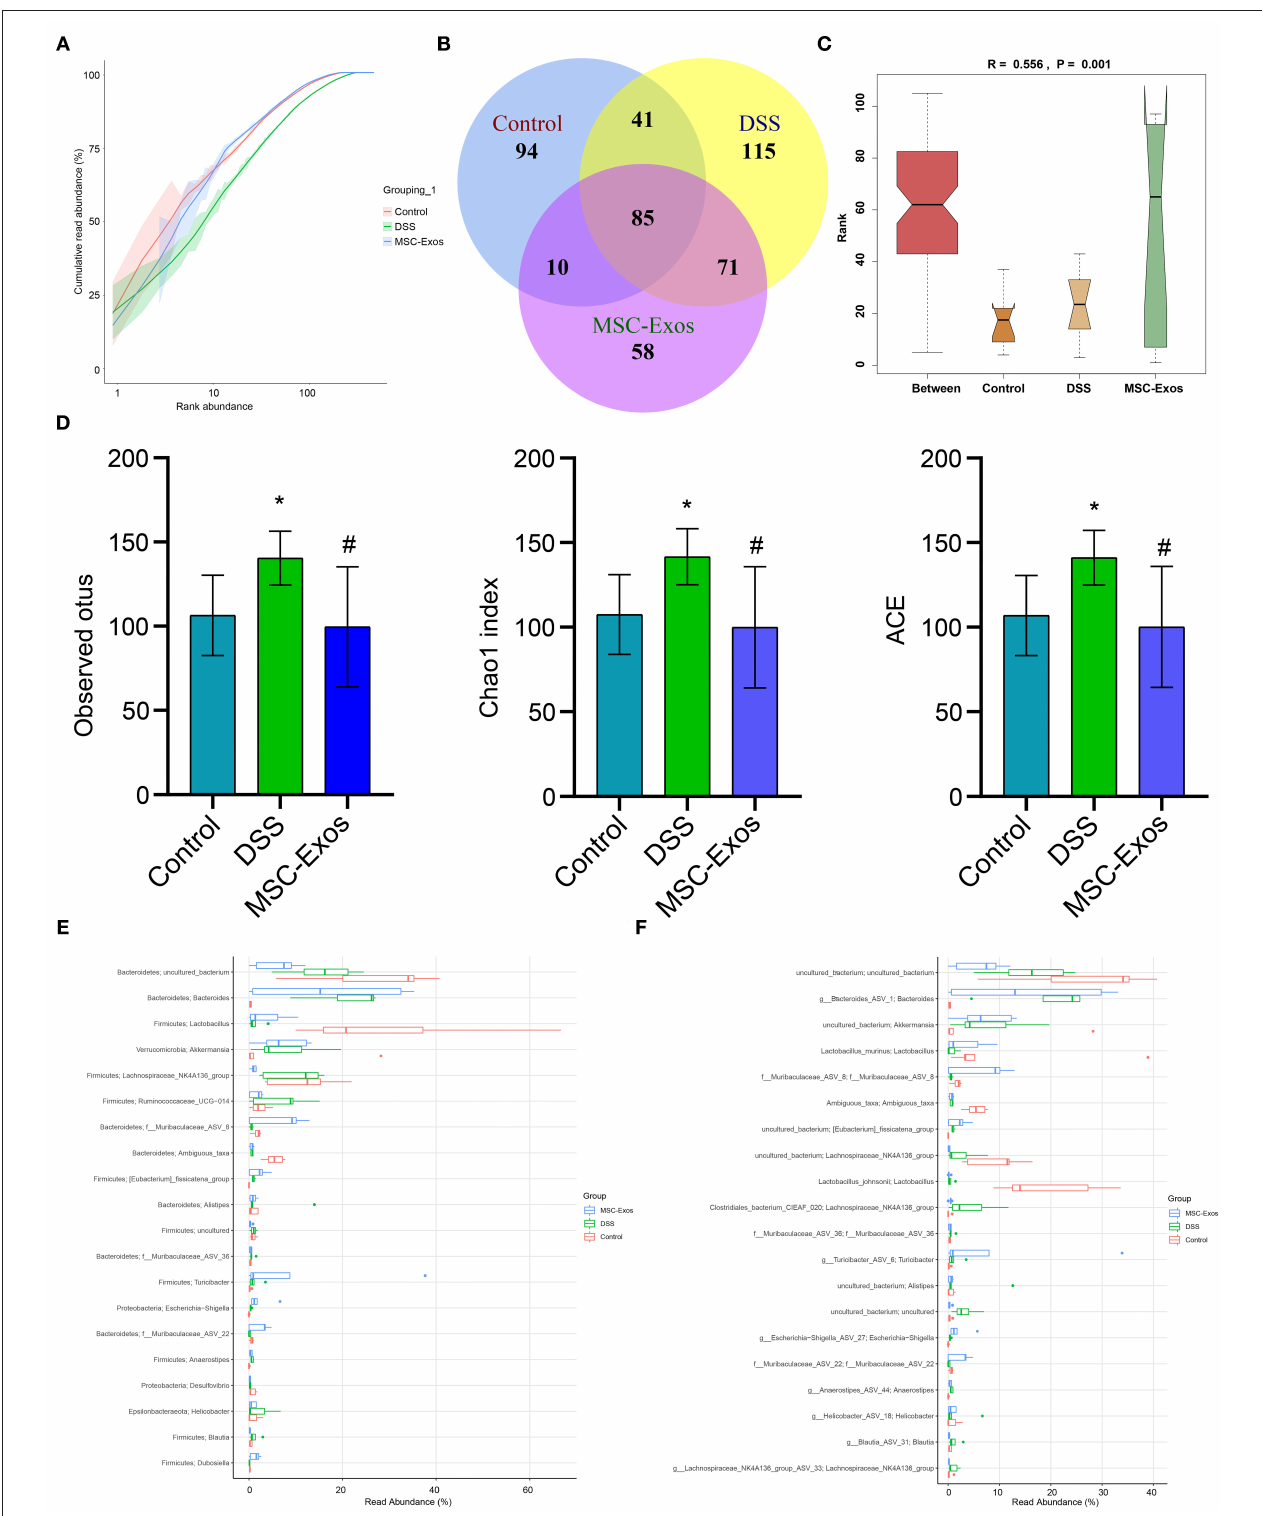
FIGURE 7 | Changes in intestinal microbiota. (A) Rank-abundance graph showing the richness and uniformity of each group. (B) Venn diagram showing the results for OTUs. (C) ANOSIM analysis showing differences in community structure among the groups. P < 0.05 indicates statistical significance. (D) Alpha diversity was used to analyze changes in the observed OTUs and Chao1 and ACE indexes. (E,F) At the genus and species levels, the relative abundance of the microbiota in the samples, respectively. * P < 0.05 vs. the control. # P < 0.05 vs. the DSS group. n = 5 mice/group. OTUs, operational taxonomic units; DSS, dextran sodium sulfate.